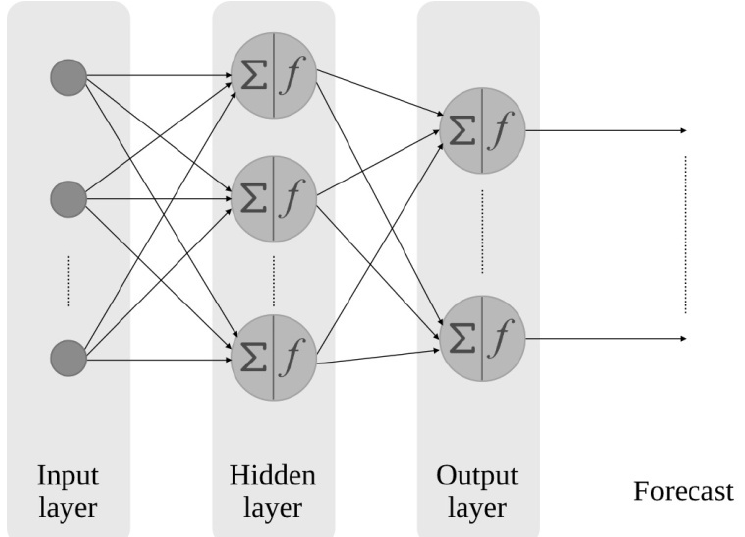
Figure 4. Structure of an FFNN.